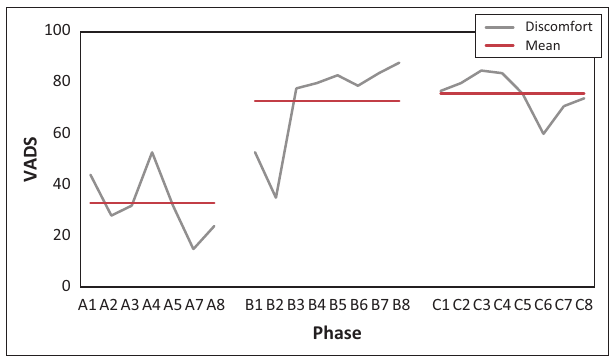
VADS, Visual Analogue Discomfort Scale. FIGURE 6: Visual Analogue Discomfort Scale measurements with the mean for each phase.